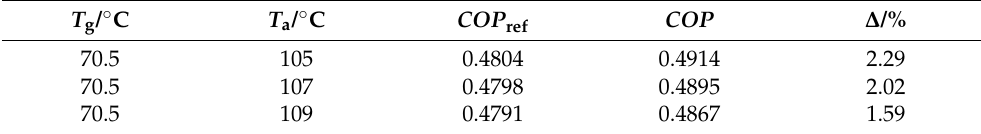
Table 1. Verification of lithium bromide-water absorption cycle compared to reference [30].